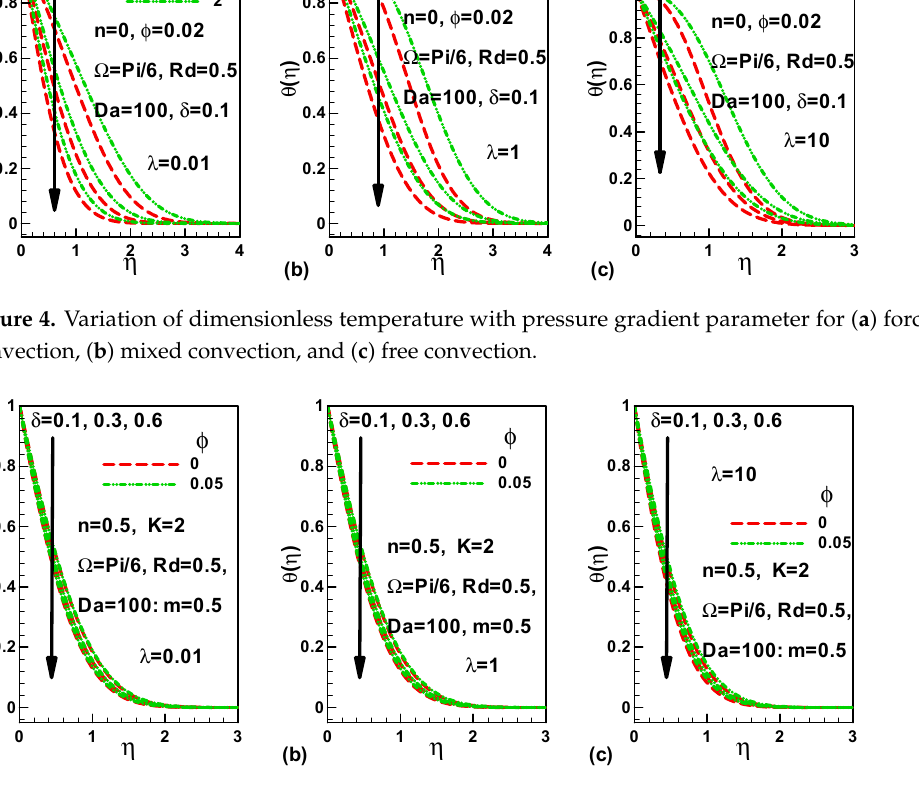
value depends upon the Richardson number.